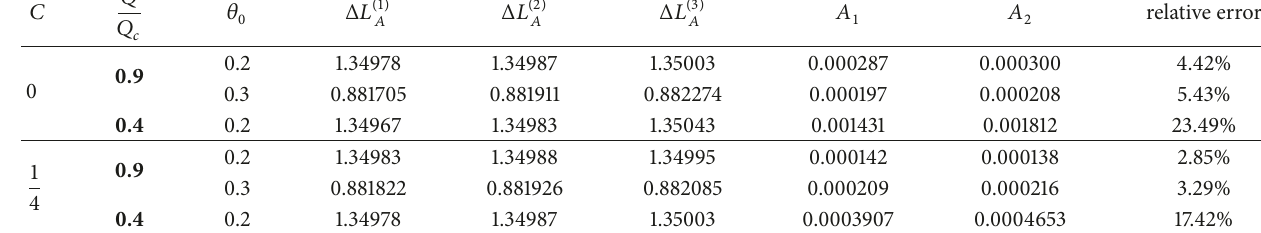
Table 4: Comparison of 𝐴 1 and 𝐴 2 for the EMYM-AdS black hole using two-point correlation function.